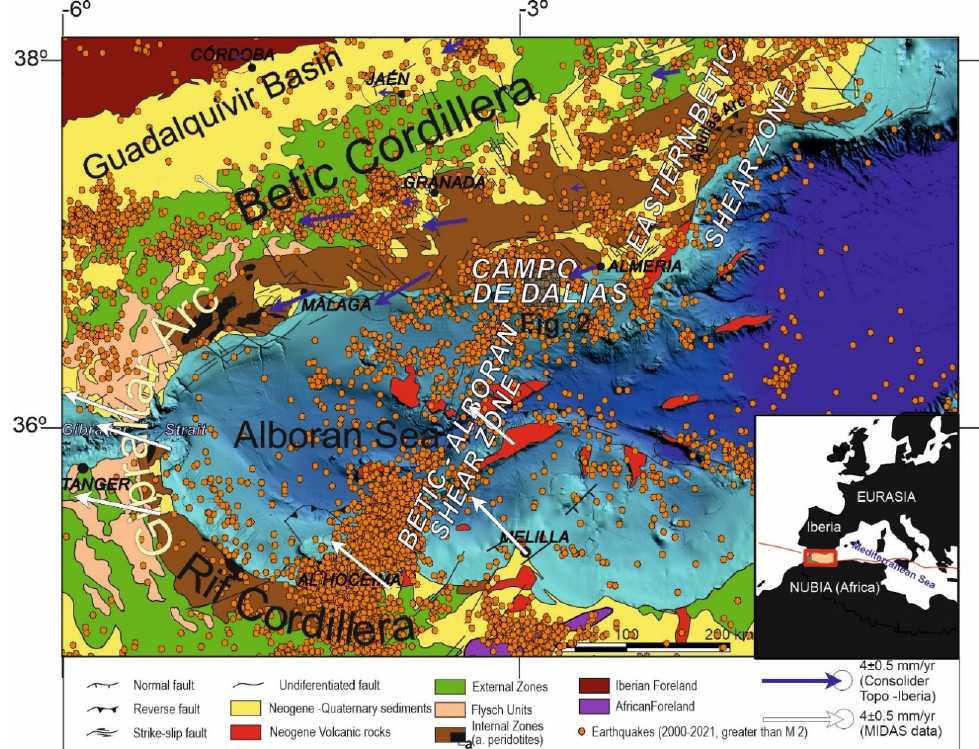
Figure 1. Regional geological setting and seismicity of the Gibraltar Arc: Major geological units are included onshore. Offshore, the main tectonic structures are indicated with detailed bathymetry. Earthquake data from IGN (www.ign.es, accessed on 1 February 2022); GNSS displacement in the central and eastern Betic Cordillera from the Consolider Topo-Iberia network [13–15], and in the Rif Cordillera, Gibraltar Strait, and central Alboran Sea from MIDAS velocity fields, Nevada Geodetic Laboratory (http://geodesy.unr.edu/velocities/midas.IGS14.txt, accessed on 20 February 2022). The location of the Campo de Dalias study area (Figure 2) is indicated.